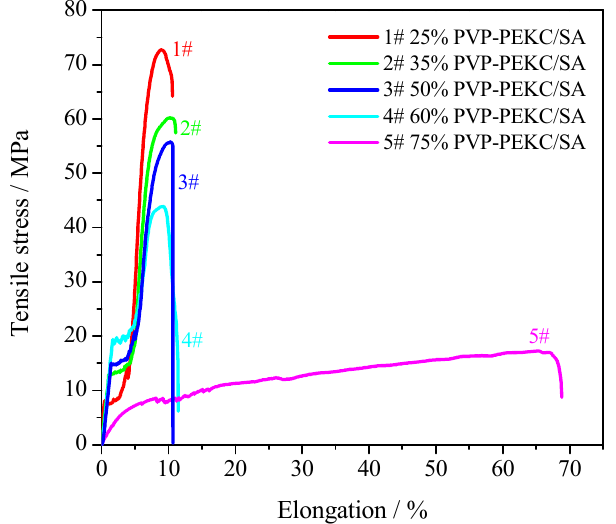
Figure 6. Tensile properties of various x%PVP-PEKC blend membranes at RT.